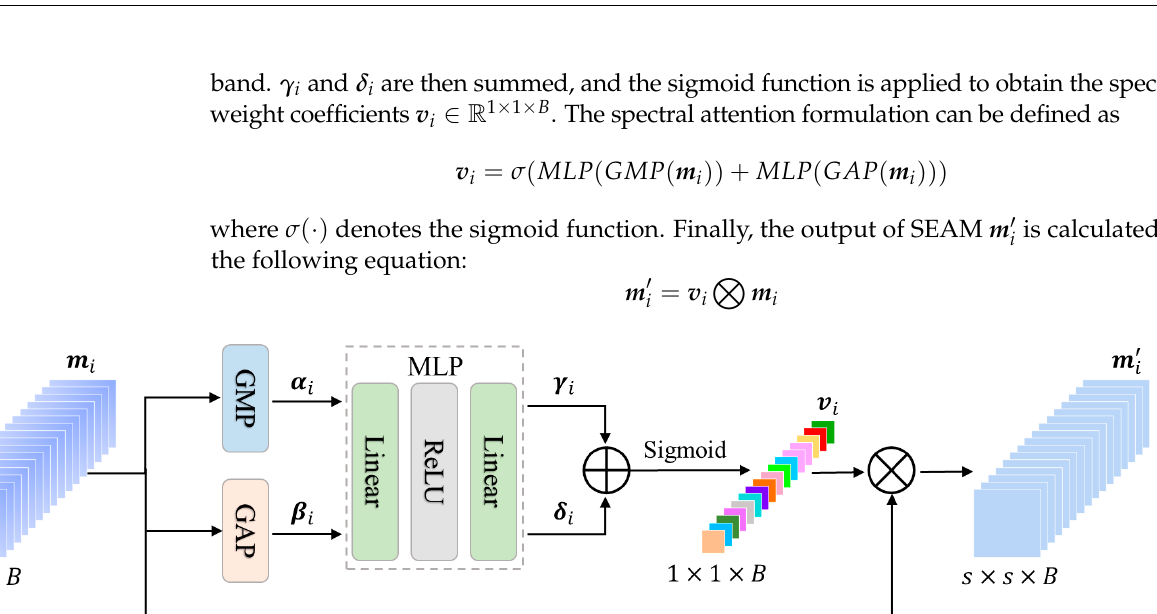
Figure 3. Detailed workflow of the SEAM.